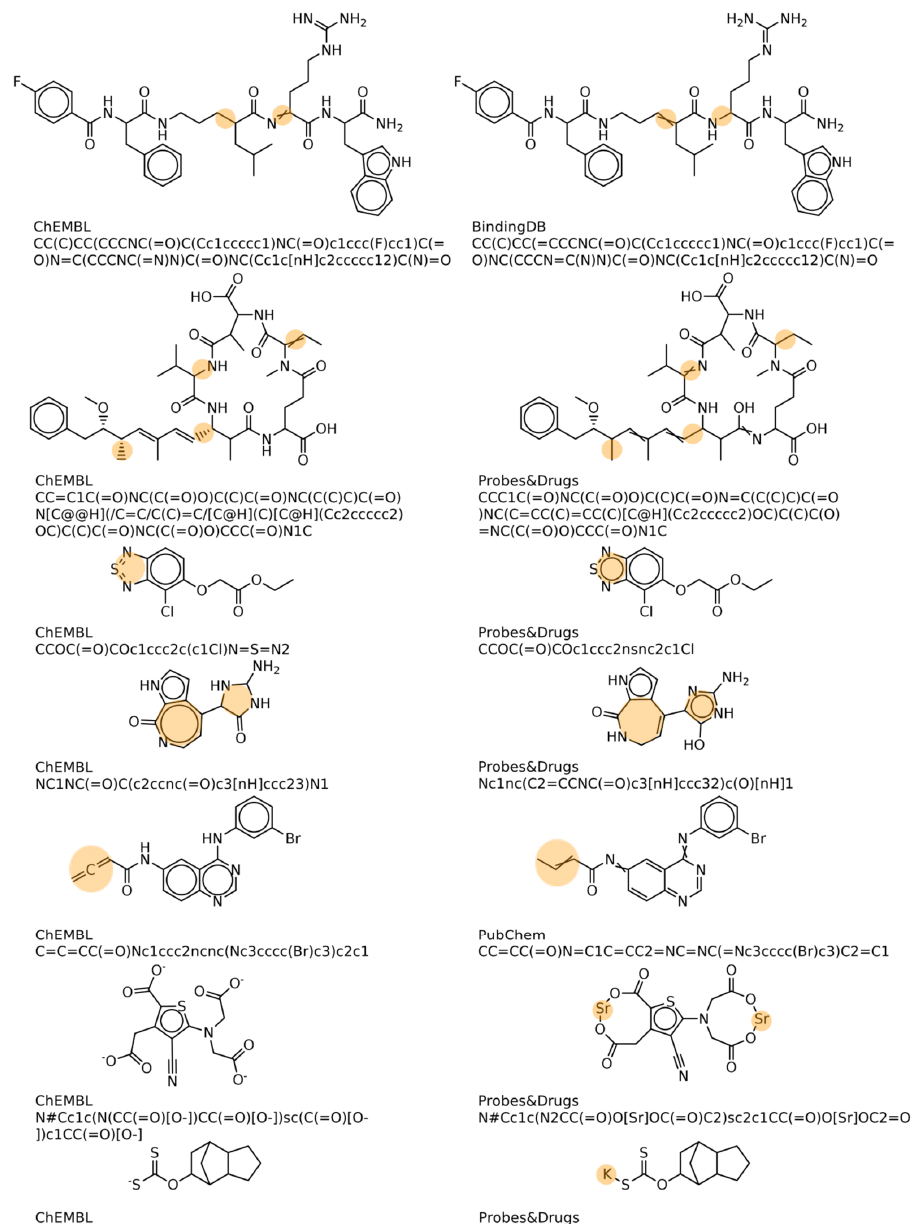
Figure 5. Differences in structural data from different source databases (examples).